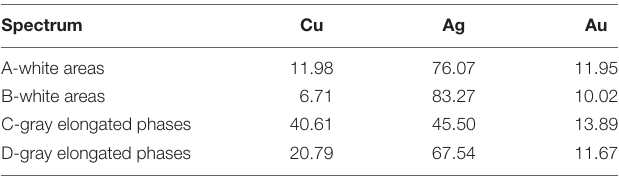
TABLE 2 | Energy-dispersive spectroscopy (EDS) elemental composition of the different areas present in the alloy matrix of the nariguera F4-03 from the tomb of the Lady of